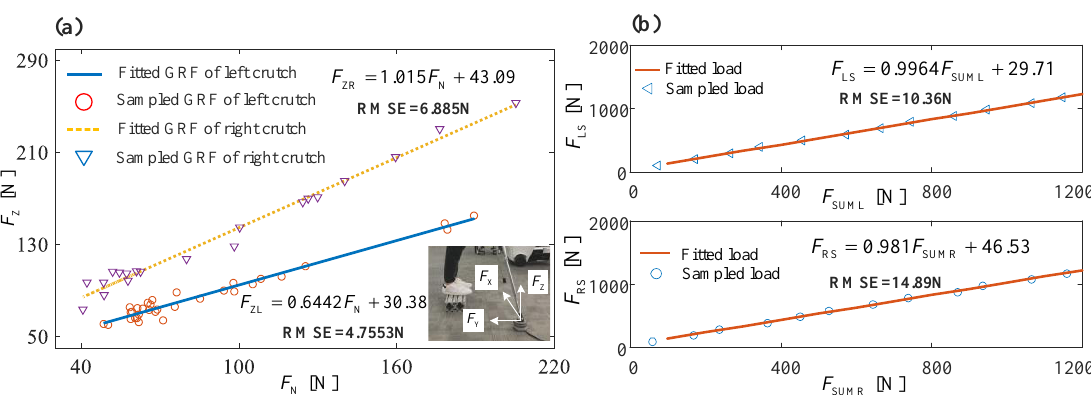
F ZL F is the F and